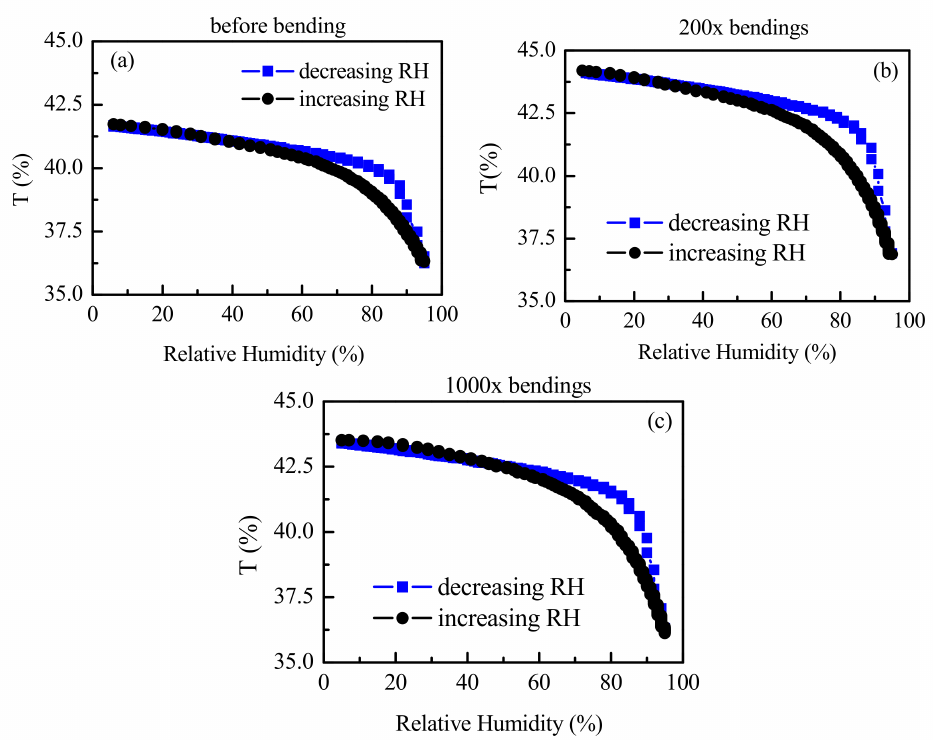
Figure 8. Dependence of transmittance T on relative humidity before ( a ), after 200 ( b ) and after 1000 ( c ) bending deformations.